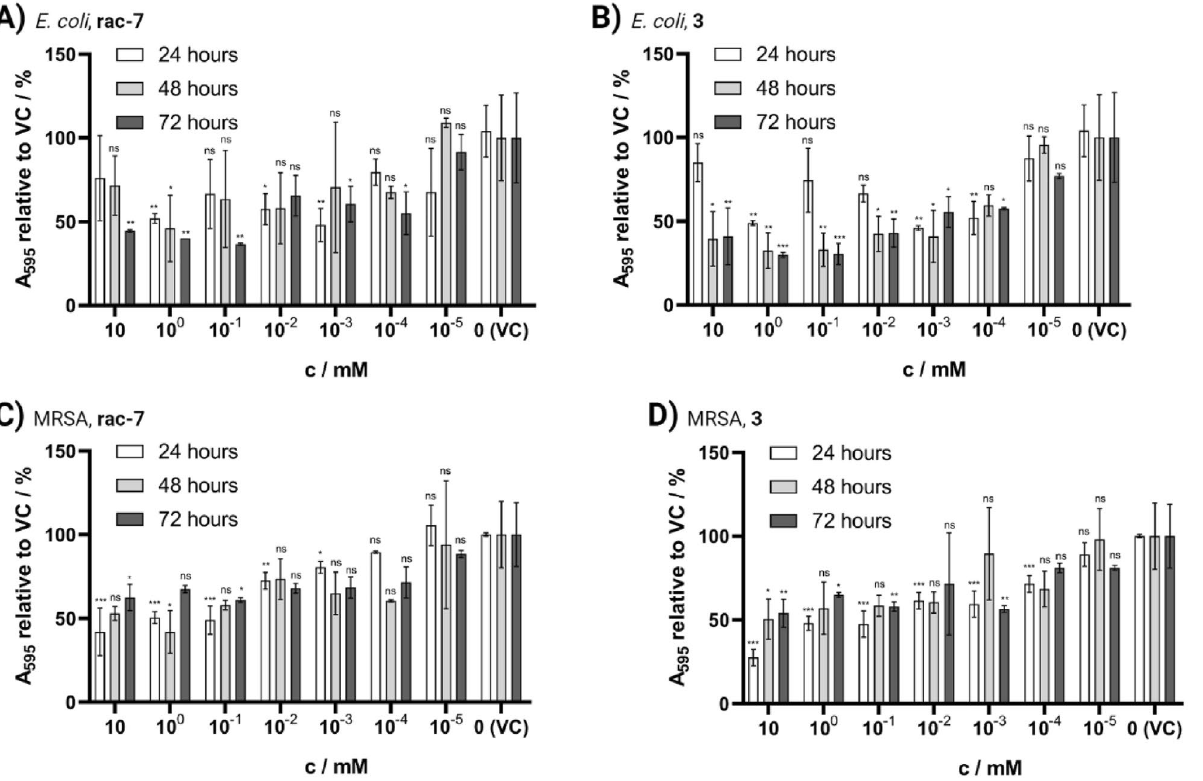
Figure 5. Evaluation of biofilm formation in the presence of CSPs with crystal violet (CV) assay. Biofilm formation of Escherichia coli ( E. coli ; A , B ) and multi-resistant Staphylococcus aureus (MRSA; C , D ) after 24, 48 and 72 h of incubation in the presence of 10 mM to 10 nM CSPs. Values are shown in relation to vehicle control (VC; PBS instead of compound stock solution) as mean ± SD (n = 2). Statistical significance was analyzed with Two-way ANOVA and Dunnett post-hoc test against respective VC ( ns not significant; *p < 0.05; **p < 0.01; ***p <